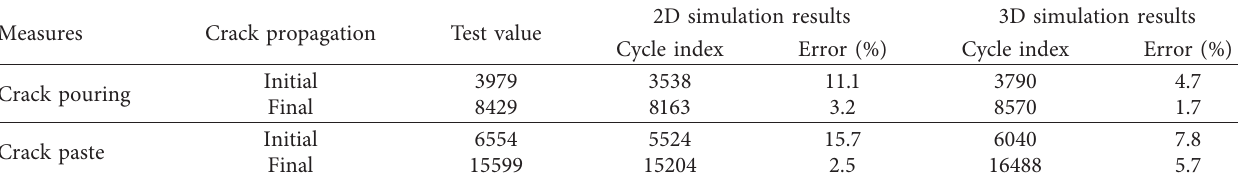
Table 5: Comparison between average values of the indoor test and the XFEM simulation results.